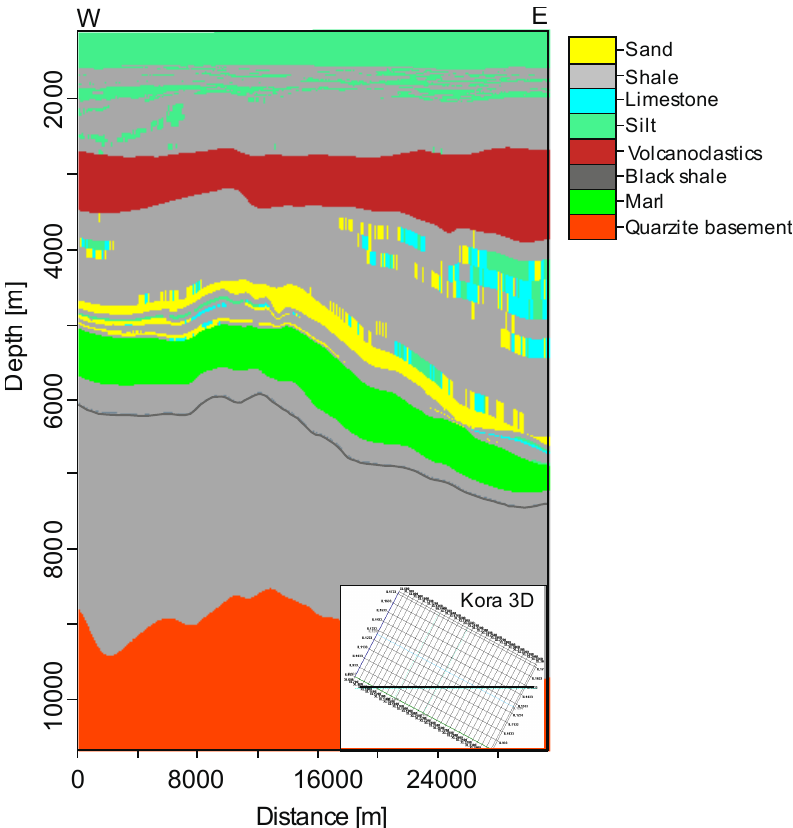
Figure 14. E-W transect through Kora 3D showing the distribution of the modeled facies.